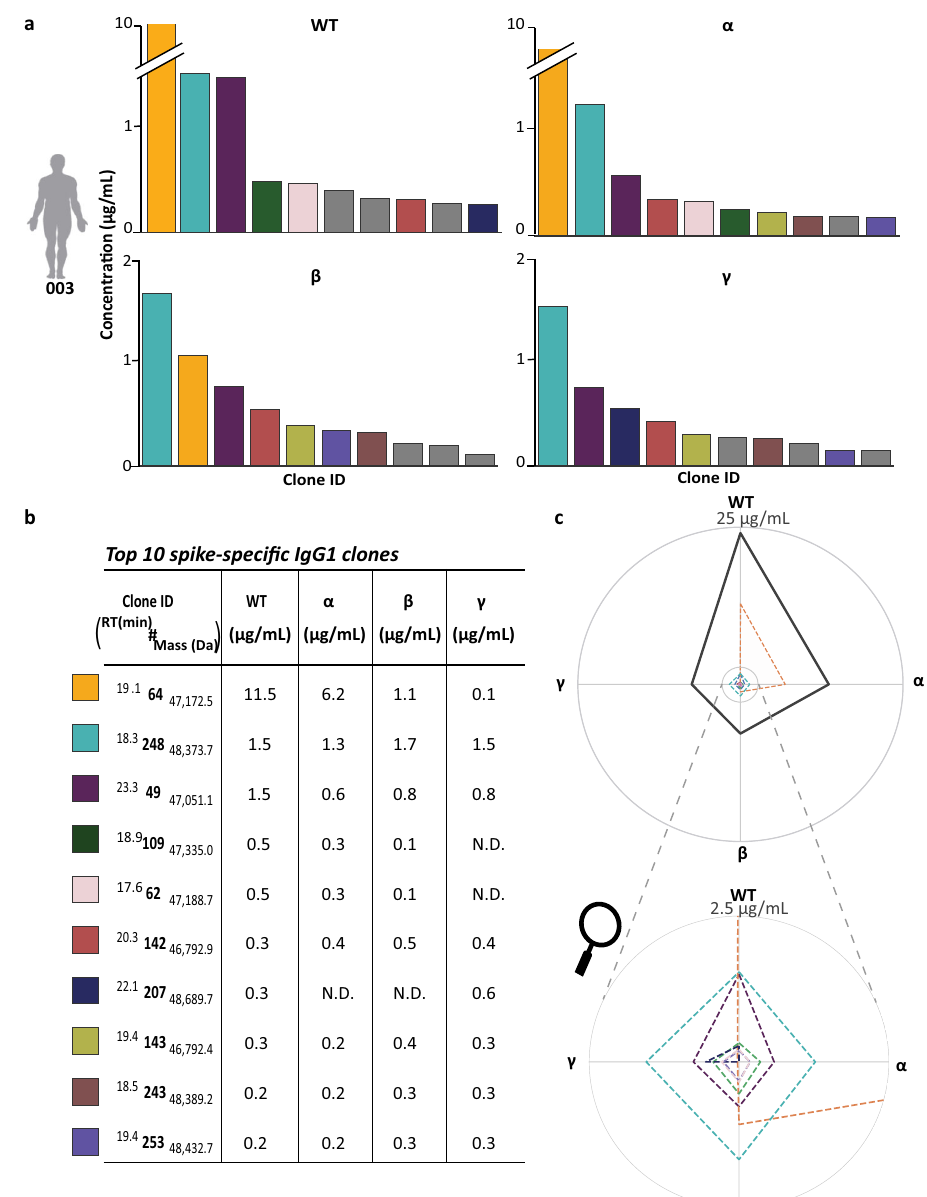
Fig. 3 | Within a single donor, antigen directed IgG1 clones display distinctive cross-reactivity versus the VOCs S-protein variants. a Quantitative comparison of the ten most abundant IgG1 Fab clones, af fi nity-enriched from the plasma of donor 003,with eachofthe fourS-protein variants.Each barrepresentsone of the 10 most abundant clones with the height indicating the concentration in µ g/ml, using the same colors for the clones corresponding to panel ( b ). Each clone that wasnotinthetotaltop10butwasinthetop10forthatspeci fi cVOCiscoloredgrey. SourcedataareprovidedasaSourceData fi le. b Top10mostabundantcloneswith data indicate that everydonor shows a unique plasmaIgG1 repertoire 7 , but also a unique anti S-protein IgG1 repertoire, with each clone showing a distinct pattern of cross-reactivity versus different variants.